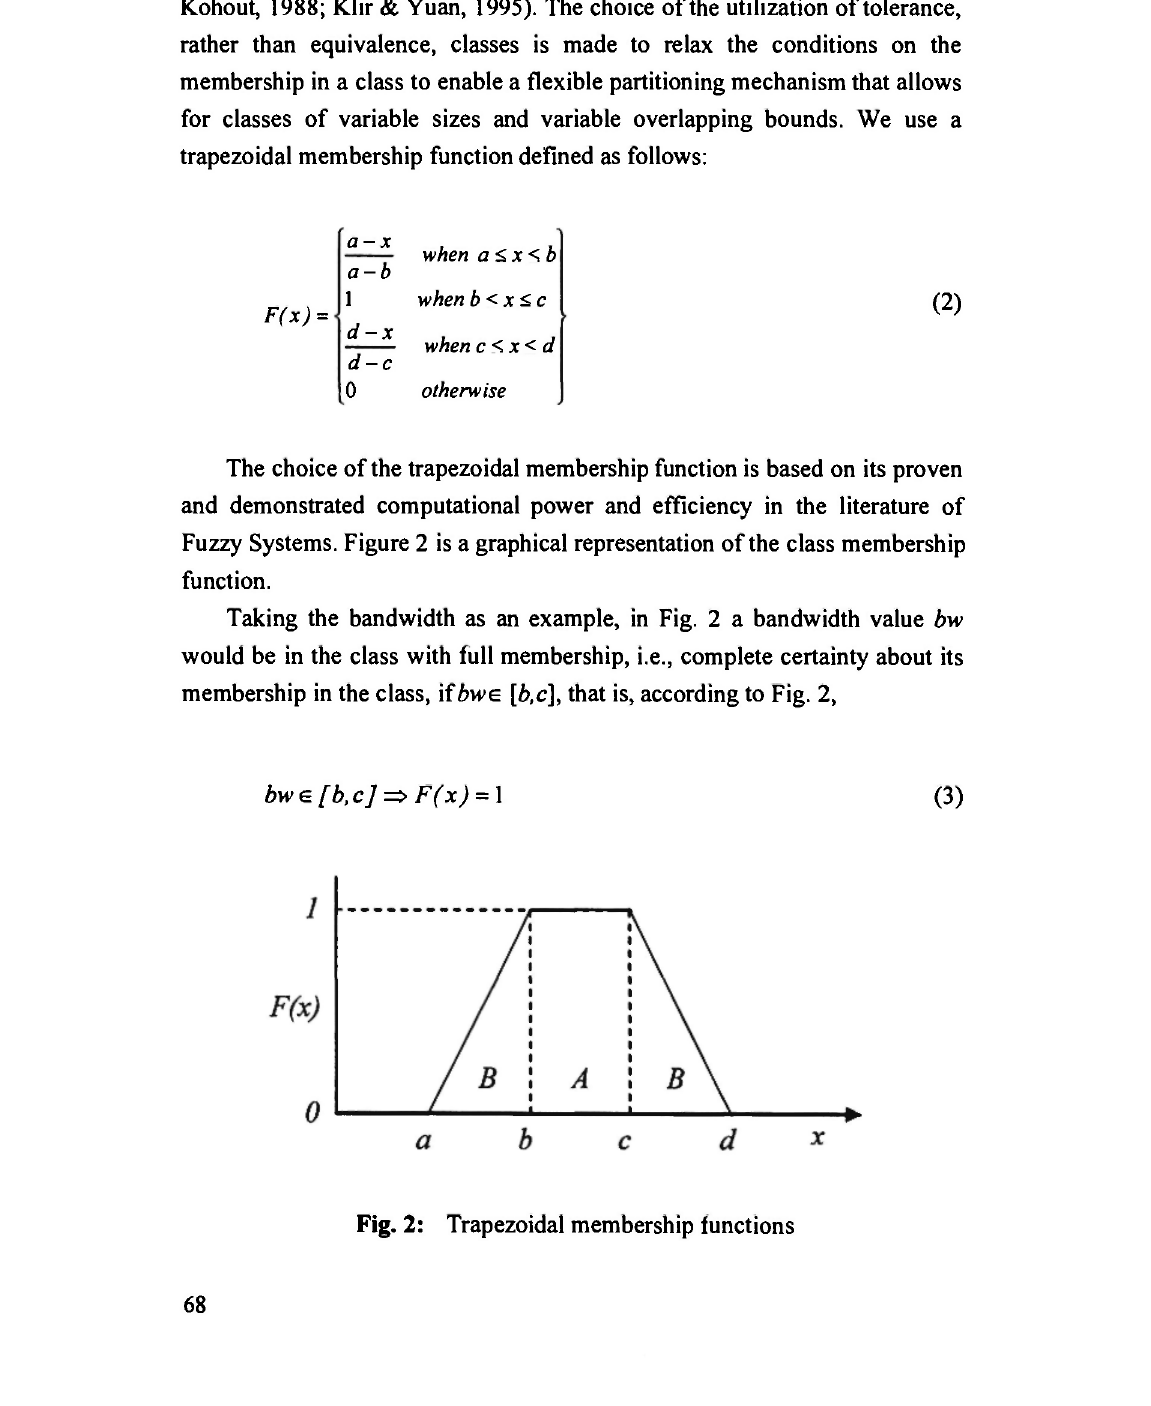
Fig. 2: Trapezoidal membership